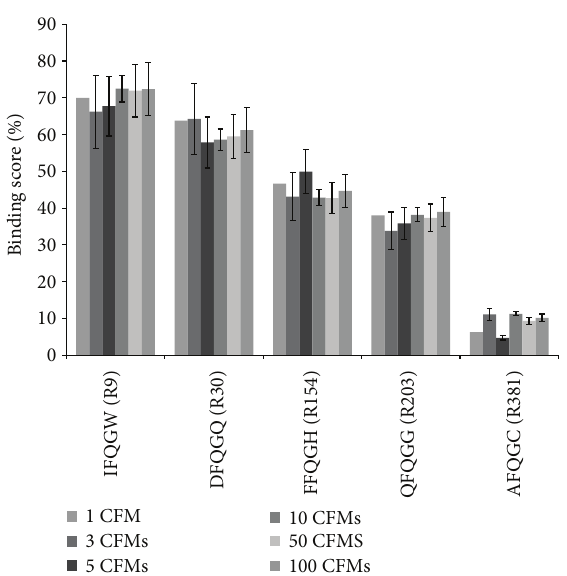
Figure 1: Conformational analysis based on 5 pentapeptides. Aver- age binding scores versus all 189 ligands of 1, 3, 5, 10, 50, and 100 pentapeptide conformers were reported in percentage. CFM: conformer, R: docking ranked position in first screening step.